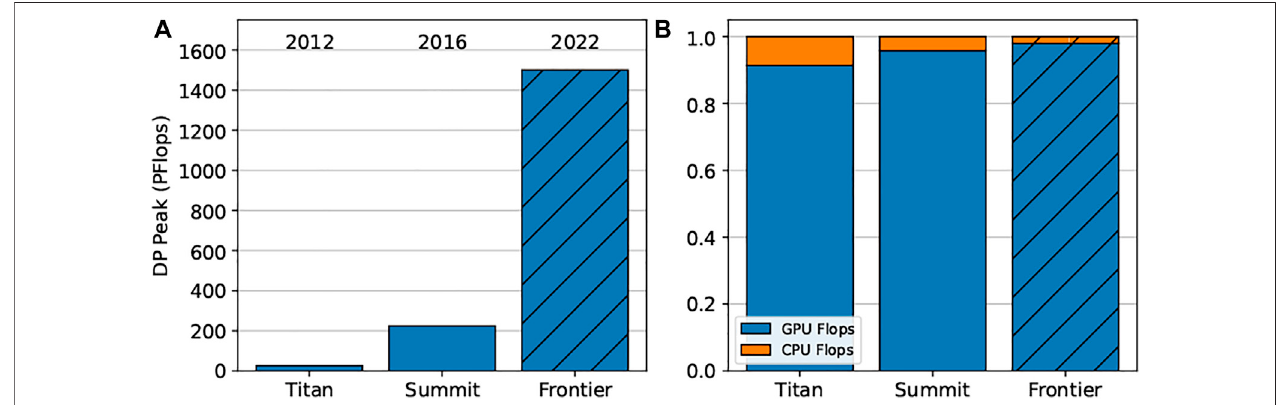
FIGURE 2 | Peak performance in Flops (A) and fraction of Flops provided by GPU and CPU (B) for GPU-accelerated systems deployed at the Oak Ridge Leadership Computing Facility (OLCF). The peak performance for Frontier is projected.